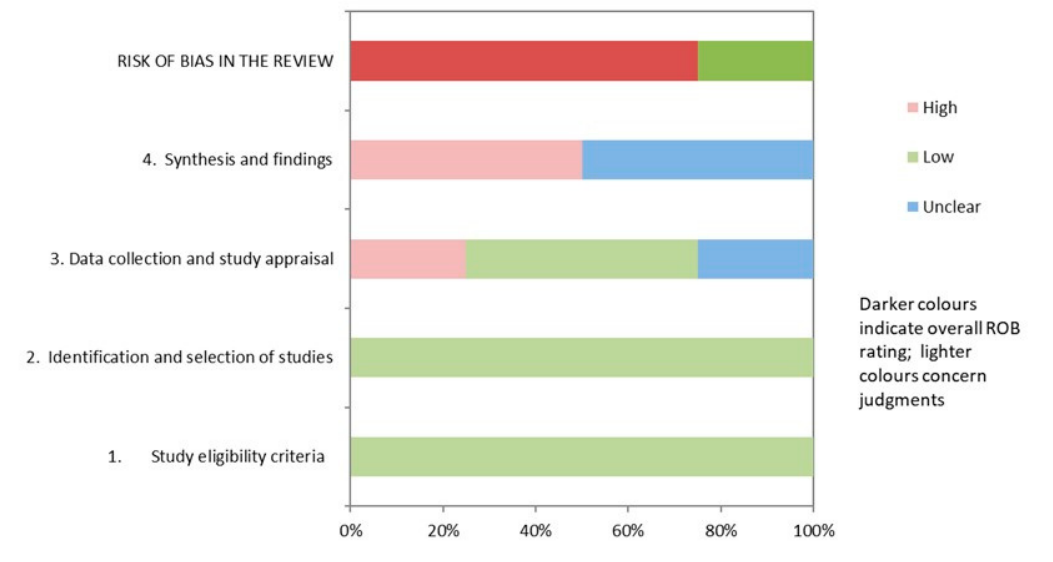
Figure 2. Graphical representation of the ROBIS results.